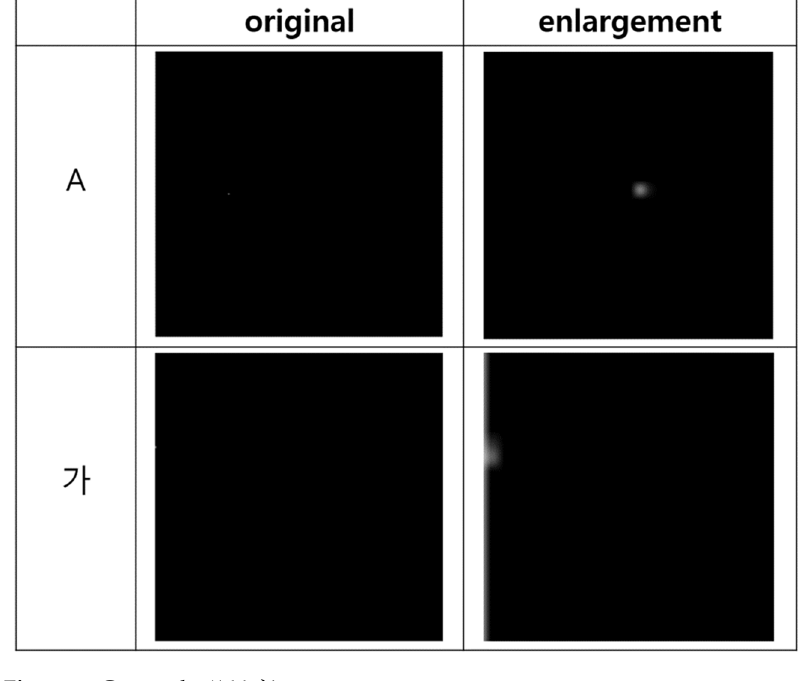
Figure 5. Grayscale, ‘A’,’ 가 ’.